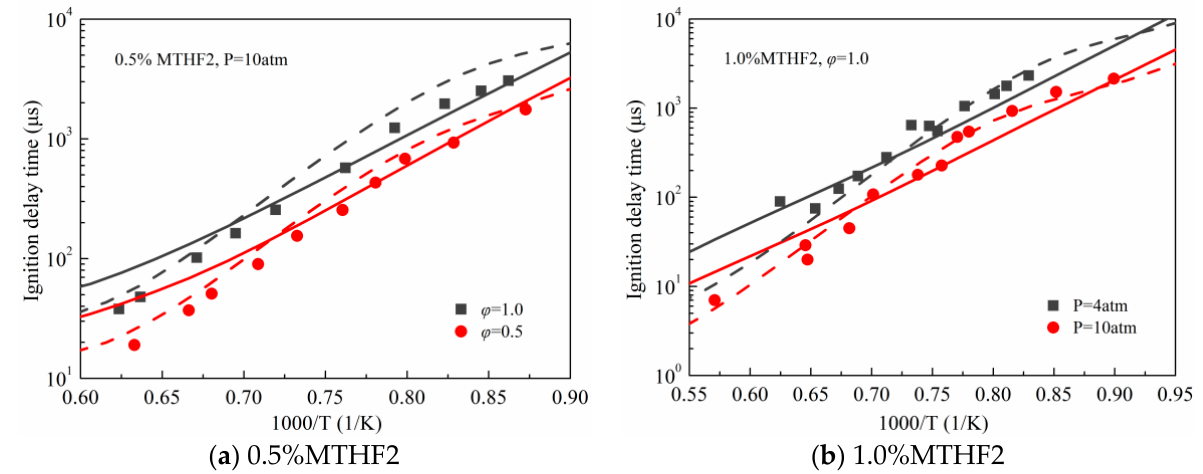
Figure 8. Measured (symbols) [19] and calculated (lines) ignition delay times for MTHF2. Solid lines: reduced diesel/MTHF2 mechanism; dashed lines: detailed MTHF2 mechanism